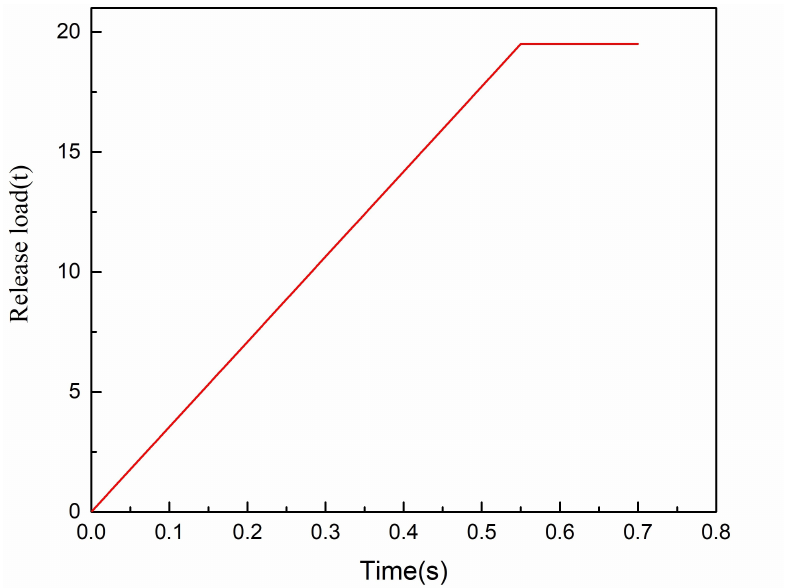
Figure 8. Holdback bar release load vs. loading